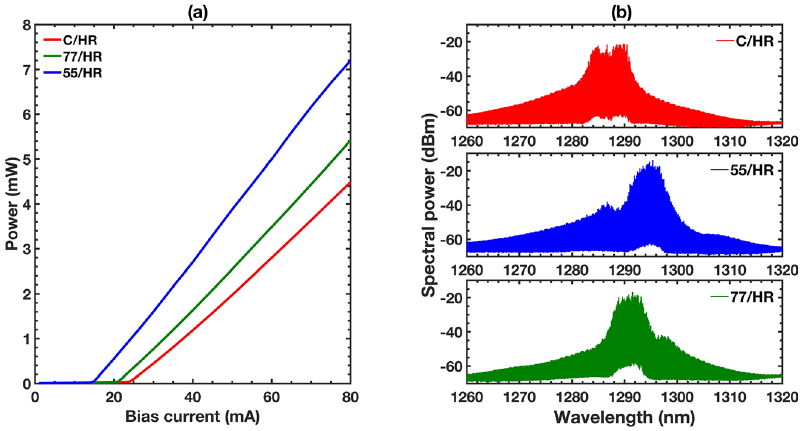
Figure 3: (a) Light-current characteristics of theQDlaserswithdifferentfacetreflectivity of C/HR, 55/HR and 77/HR, respectively; (b) Optical spectra measured at 3 × I s for QD lasers with different facet re fl ectivity of C/ HR, 55/HR and 77/HR,